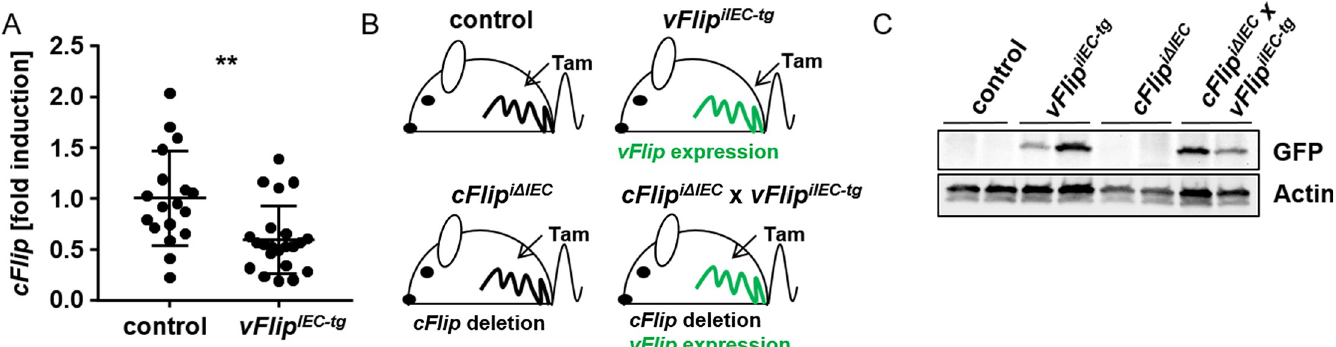
Fig 1. Analysis of vFLIP-regulated cFlip expression and generation of an inducible mouse model. (A) Gene expression analysis of cFlip in control and vFlip IEC-tg mice; n � 18. Fold induction values were calculated relative to controls, Hprt was used as a housekeeping gene. (B) Generation of mouse models to induce vFlip expression (linked to Gfp expression) and/ or to delete cFlip expression respectively in IECs of mice after at least 2 days of consecutive intraperitoneal tamoxifen injection. (C) Western Blot analysis of GFP in small intestinal lysates of indicated mice after 2 consecutive days of tamoxifen injection. Actin was used as a loading